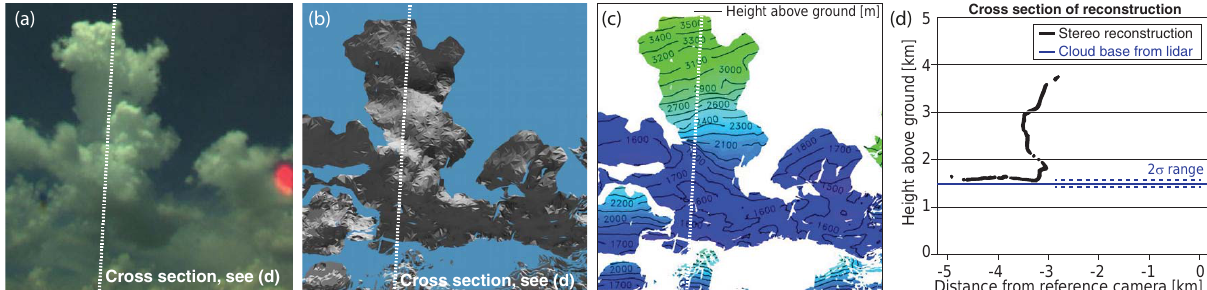
Figure 15. Three-dimensional reconstruction of a cumulus tower from a stereographic photograph from 24 July 2014, 11:32:00UTC. Shown are (a) a subsection of the image obtained from the reference camera, (b) the reconstruction as an untextured triangulated surface mesh, (c) the colour-coded height of the reconstruction with contour lines, and (d) the reconstructed distance of the cloud edges from the reference camera obtained along the cross section (dashed line) shown in (a) , (b) , and (c) as well as a comparison of the cloud base with the one observed with lidar ceilometer (blue line). Adapted from Beekmans et al. (2016).